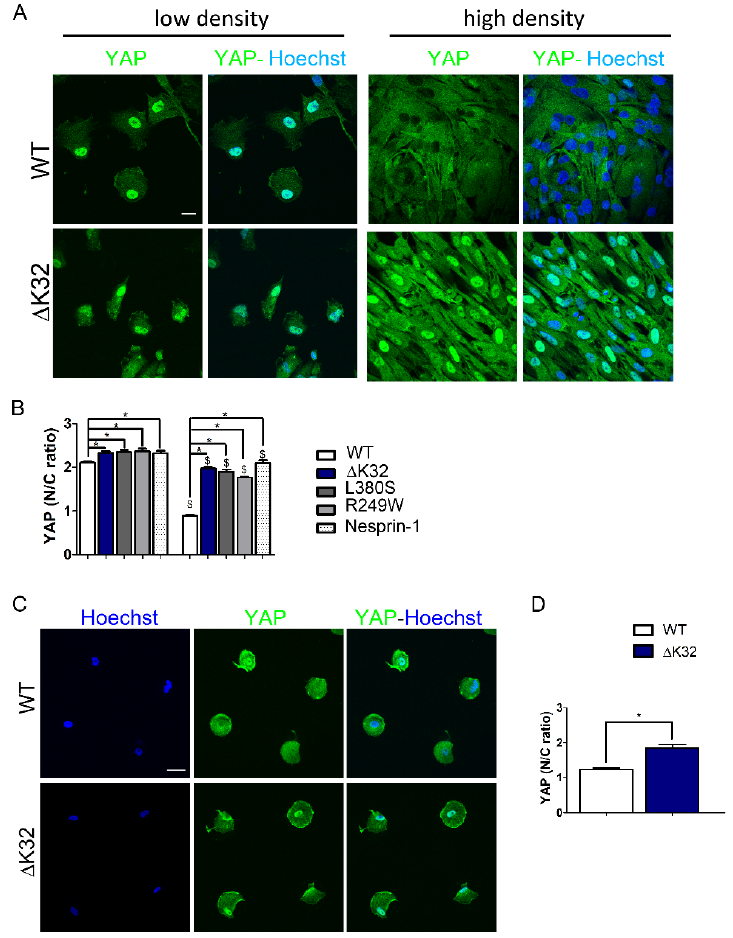
Figure 1. Modulation of yes-associated protein (YAP) localization in wild-type (WT) and mutant muscle stem cells (MuSCs). ( A ) Confocal images of YAP (green) in WT and LMNA ∆ K32 mutant MuSCs cultured in low and high density conditions. Nuclei are stained with Hoechst (blue). Scale bar: 20 µ m. ( B ) Quantification of YAP nucleo-cytoplasmic (N/C) ratio in WT, LMNA Δ K32 , LMNA L380S , LMNA R249W , and nesprin-1 KASK mutant MuSCs. Pooled values of WT (WT1 and WT2) are presented. Values are expressed as mean ± SEM, n = 200 cells for each cell line. * p < 0.05 vs WT; $ < 0.05 vs. corresponding sparse condition. ( C ) Micro-patterning modulation of YAP. Confocal images of YAP (green) in WT and LMNA Δ K32 cells cultured on small ECM substrate that limits cell spreading. Nuclei are stained with Hoechst (blue). Scale bar: 30 µ m. ( D ) Quantification of YAP nucleo-cytoplasmic (N / C) ratio on small ECM substrates. Values are expressed as mean ± SEM, n ≥ 62 cells for each cell line. * p < 0.05 vs.